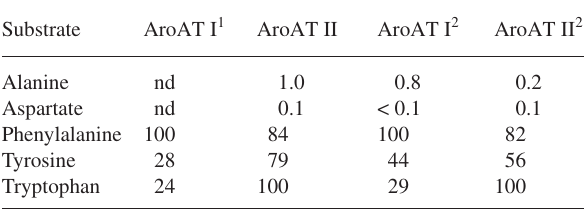
Table 3. Substrate specificity of AroATs from Pyrococcus furiosus and Thermococcus litoralis , expressed as relative maximal activity (%). Abbreviation: nd = not